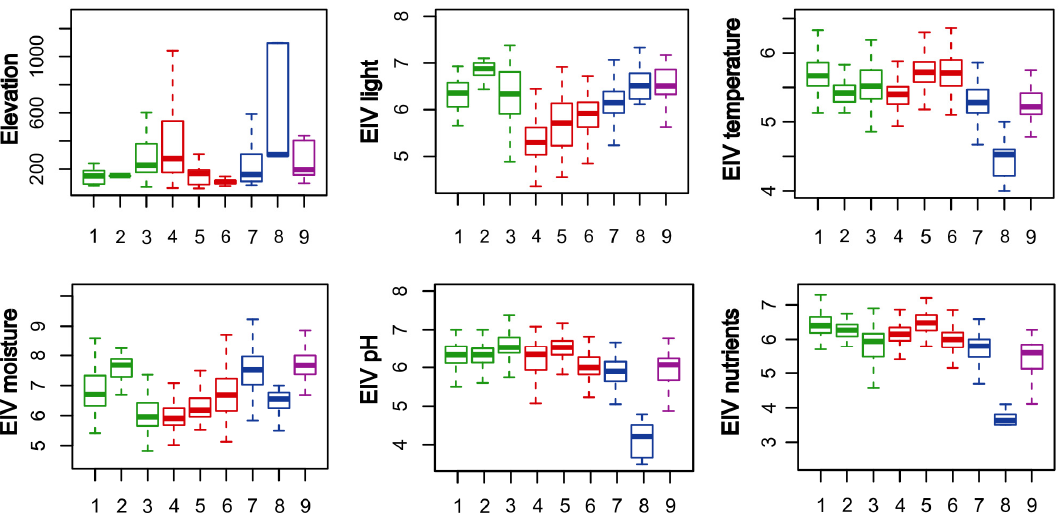
Figure 4. Comparison of the selected EIVs and elevation among clusters. Boxes indicate the 25–75% interquartile range with their median (bold line). Cluster numbers correspond to Table 1, Figures 2 and 3, Tables S1–S4, Appendix C and to those used in the text. The colors represent groups of clusters (classes): Salicetea purpureae (green), Alno-Populetea (red), Alnetea (blue) and Franguletea (purple).